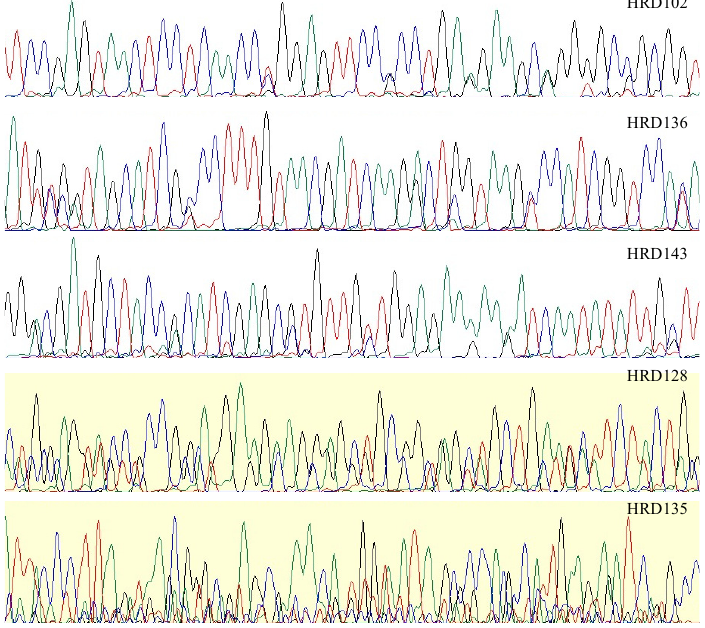
Figure 2. Chromatograms of the mixed samples showing a few overlapping peaks (HRD102, HRD136, and HRD143) to a completely unreadable DNA sequence (HRD128 and HRD135).